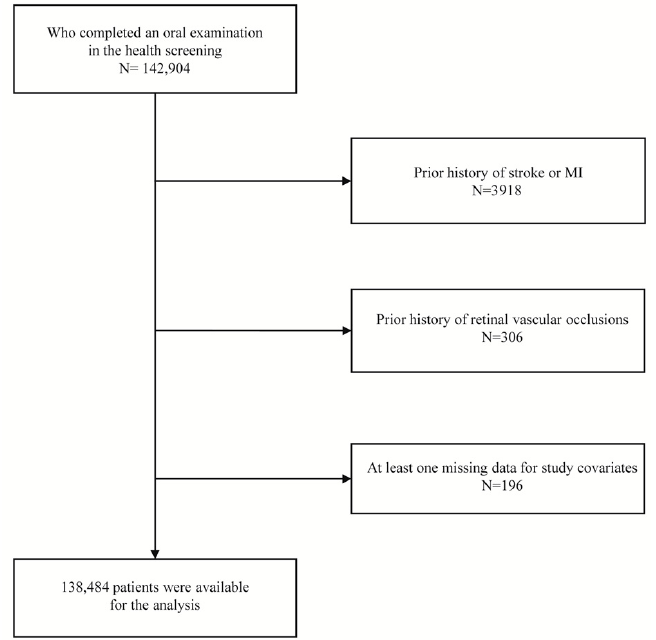
Figure 1. Flow chart of inclusion and exclusion criteria.